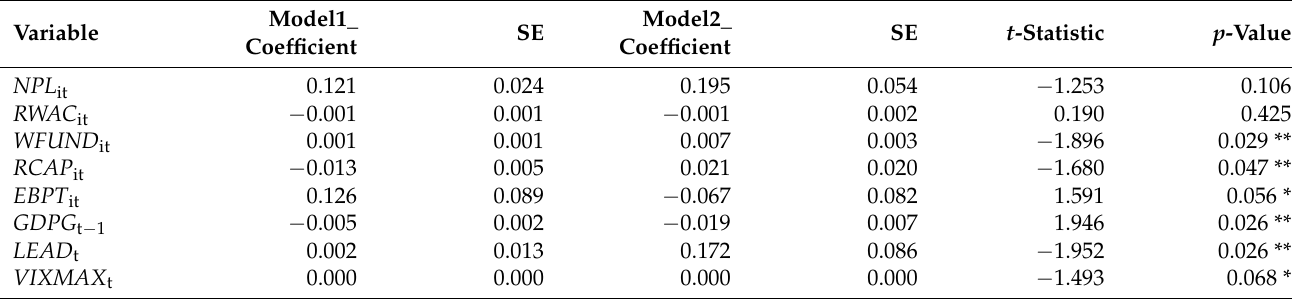
Table A4. Comparison of pre-crisis (1) and crisis (3).